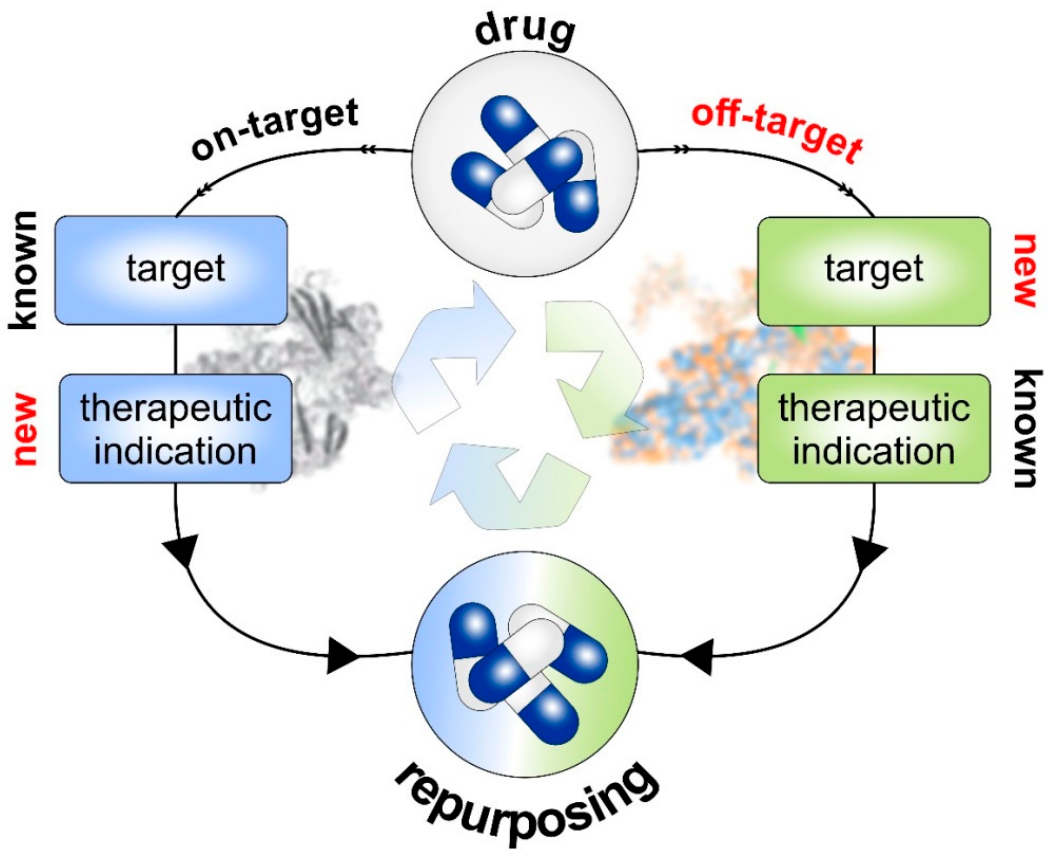
Figure 2. On-target and off-target strategies of drug repurposing. The on-target pipeline only considers drugs with known target(s). Once the target is identified and validated in the patho-physiology of new disease therapeutic indication, the drug may also be repurposed for that. In case of off-target strategies, drugs are screened against already prioritized therapeutic targets of disease under investigation.